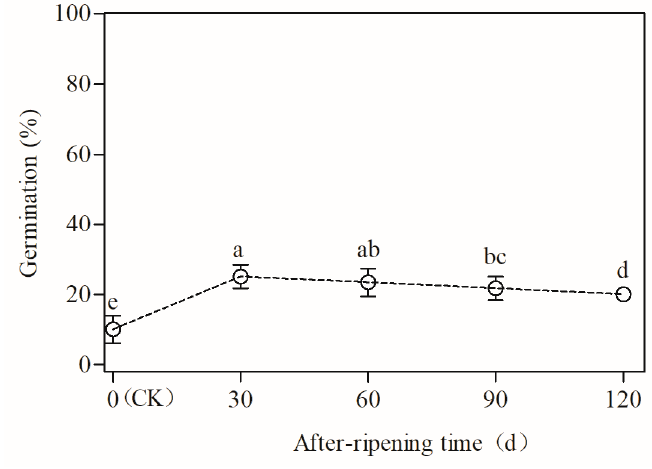
Figure 5. Effects of after-ripening on the dormancy release and germination of E. ulmoides seeds. Seeds treated with after-ripening for different days were incubated for 30 days at 10 °C in the dark and the germination percentage was calculated (mean ± standard error). Each treatment had four replicates and 30 seeds were used for each replicate. There are no significant differences between the data labeled with the same lower-case letters ( p = 0.05).